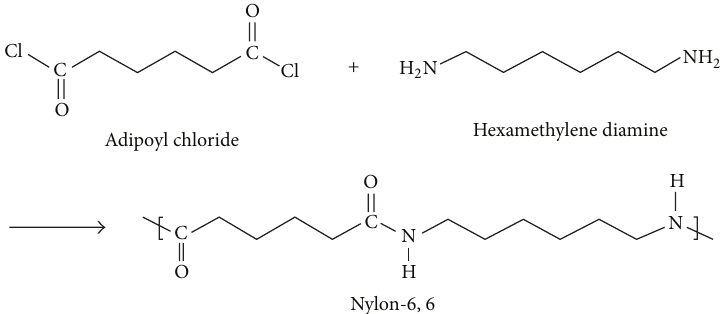
Figure 1: Characteristic synthesis of nylon-6,6